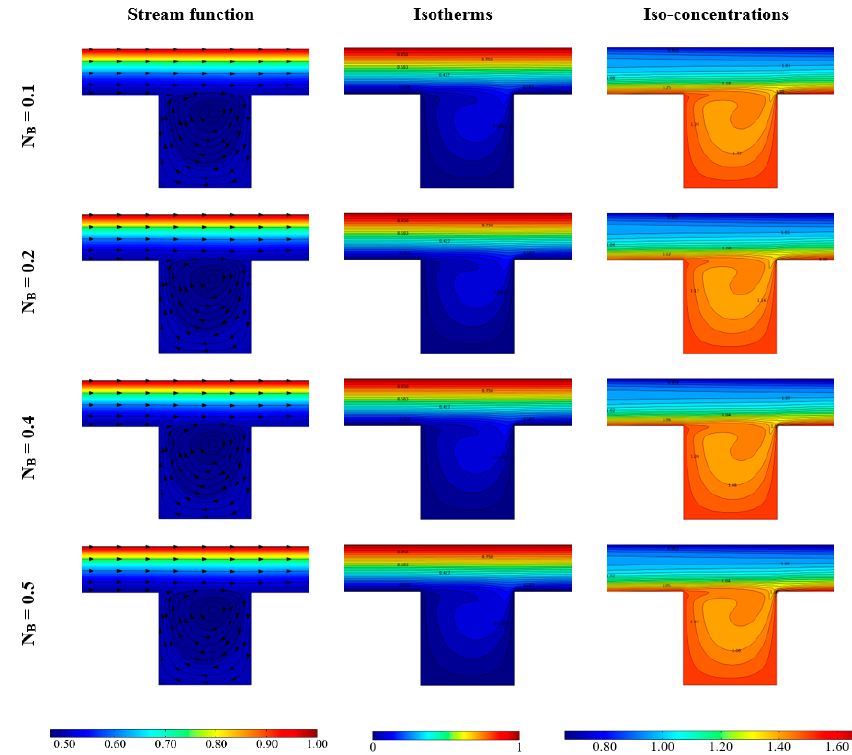
Figure 5. Stream function, Isotherms and Iso-concentration for various N B number and Pr = 6.2, Re = 100, Le = 1, N T = 0.1.